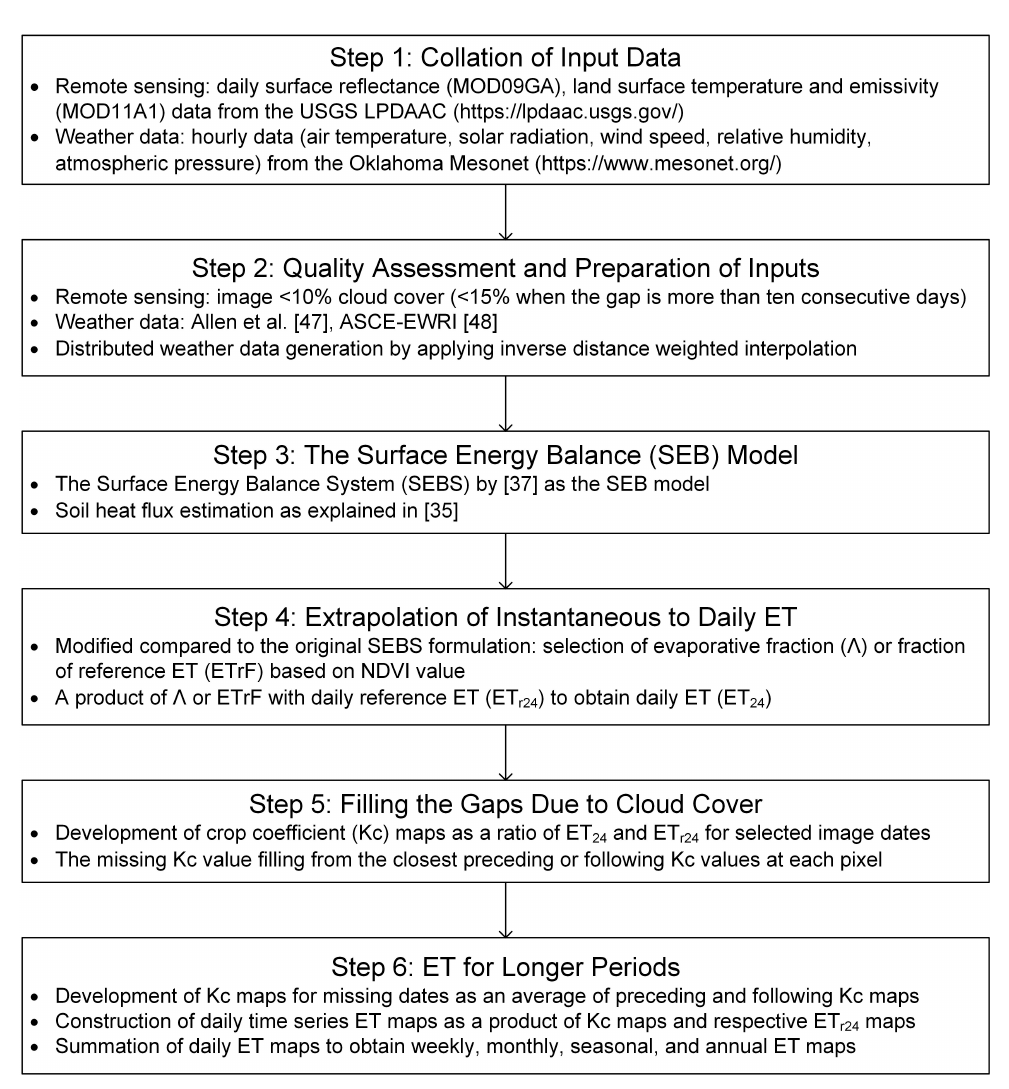
Figure 2. A descriptive flow diagram of the daily time series of evapotranspiration (ET) modeling